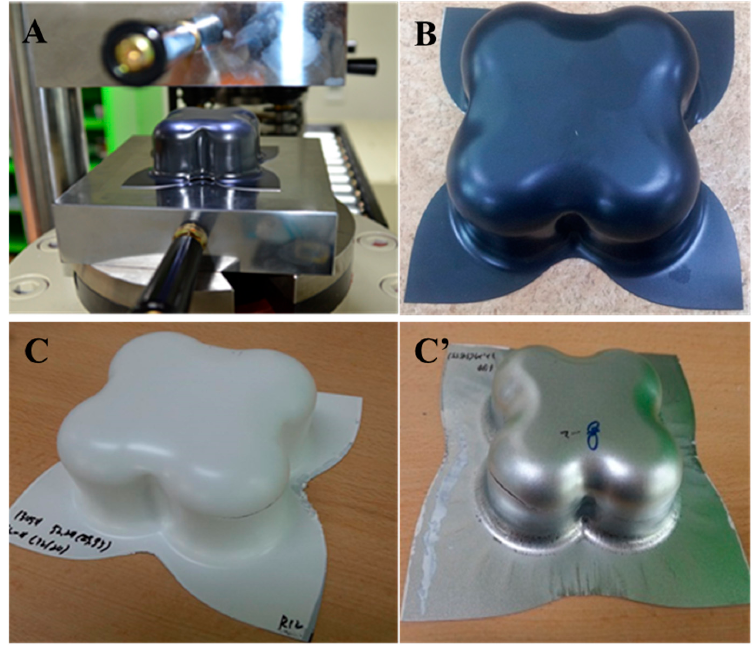
Figure 2. Cross-die cup drawing mold and press for PCM: ( A ) Cross-die drawing mold, ( B ) cross-die drawing sample (mom-fractured), ( C , C’ ) cross-die drawing sample (fractured).